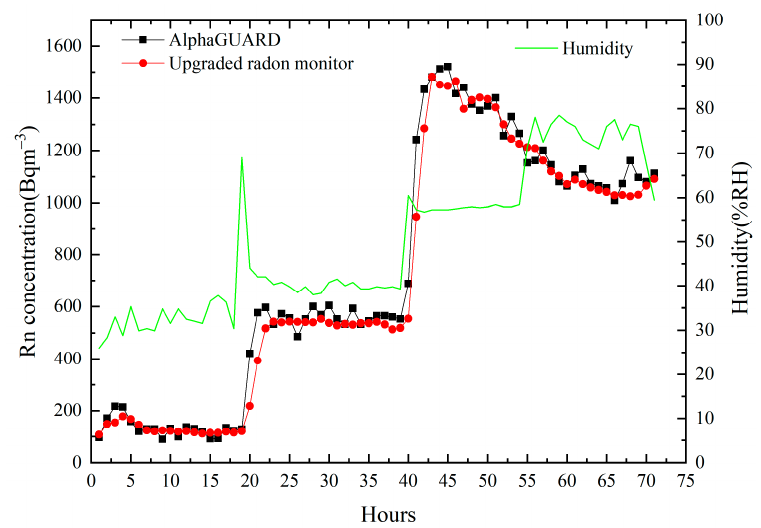
Figure 6. Results of comparison between the upgraded radon monitor and AlphaGUARD at different levels of radon concentrations and relative humidity.